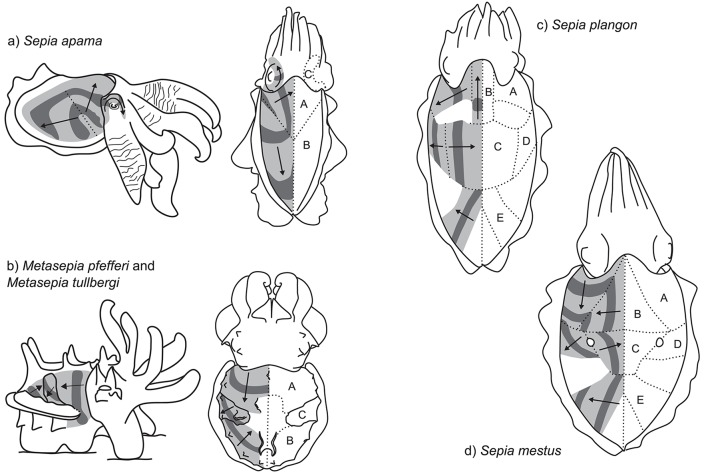
Multidirectional passing wave patterns. (a)
Sepia apama: left—competitive display produced by rival males during the spawning aggregation; right—dorsal view of the two motion fields (without skin stretch). (b) The dynamic pattern of the two closely related species, Metasepia pfefferi and M. tullbergi: left—lateral view; right—dorsal view. (c)
S. plangon (dorsal view). (d)
S. mestus (dorsal view).